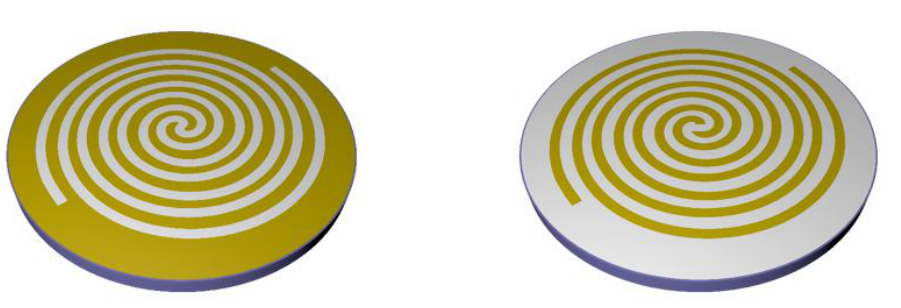
Figure 6. Slot-spiral structure ( left ) and spiral structure ( right ) both integrated with high-electron- mobility transistor (HEMT) in the